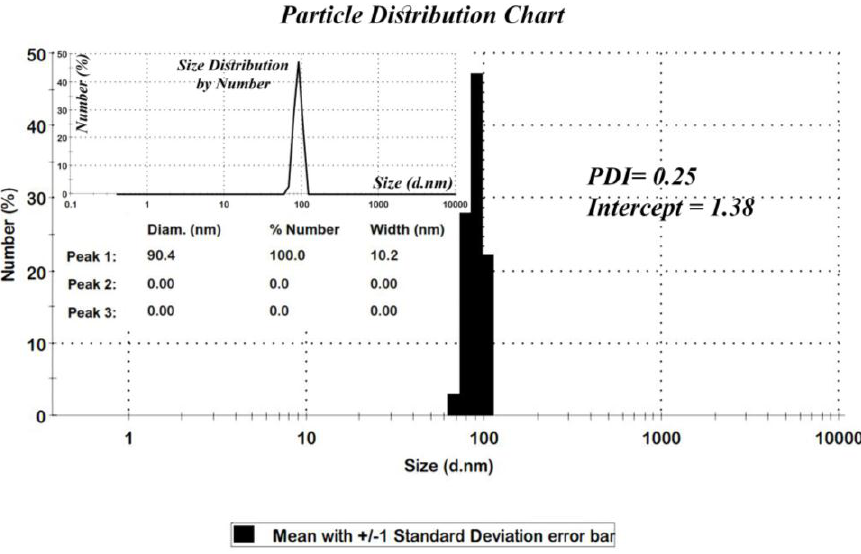
Figure 3. Size distribution histogram of nano-MIL-100.